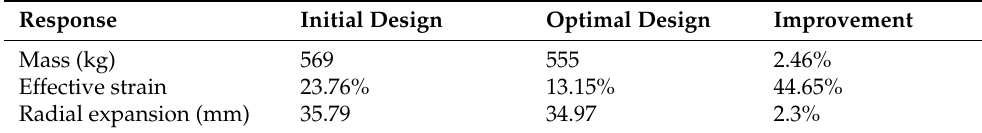
Table 6. Performance